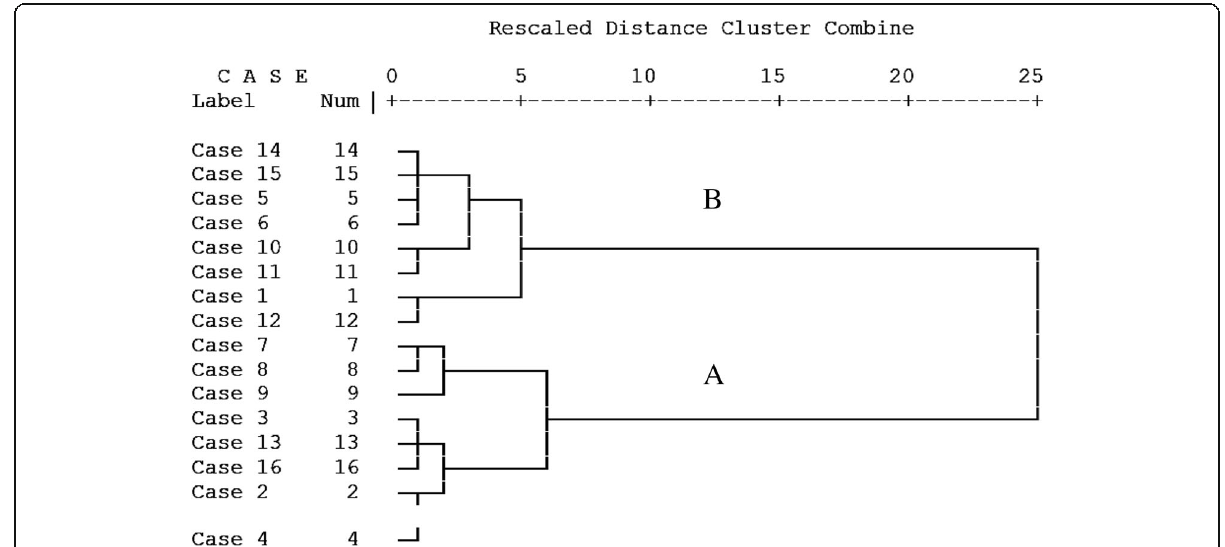
Fig. 2 Dendrogram providing a graphic summary of the clustering